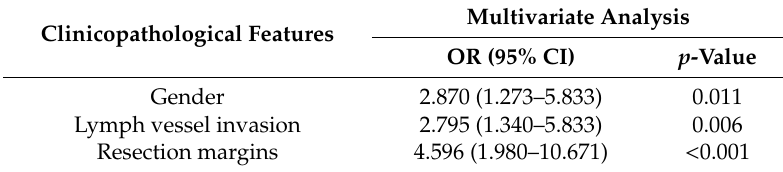
Table 2. Multivariate logistic regression analysis regarding recurrent / persistent